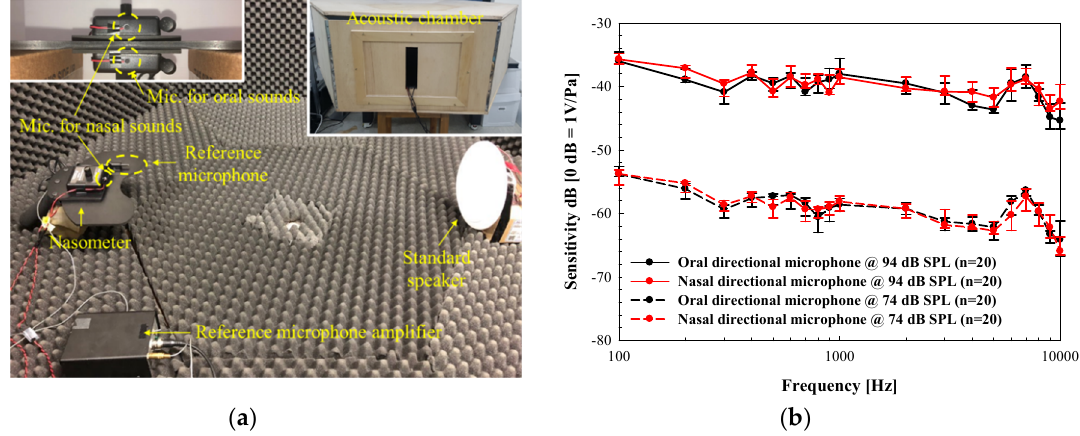
Figure 3. Experimental environment ( a ) picture and ( b ) sensitivity results of the attached microphone ((Electret Condenser Microphone, ECM) sensitivity in the nasometric instrument.